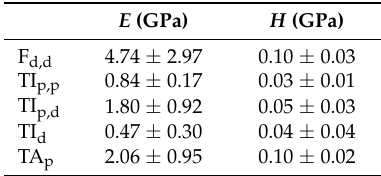
Table 2. Material properties of the cuticle of contacting surfaces in leg joints of P. marginata